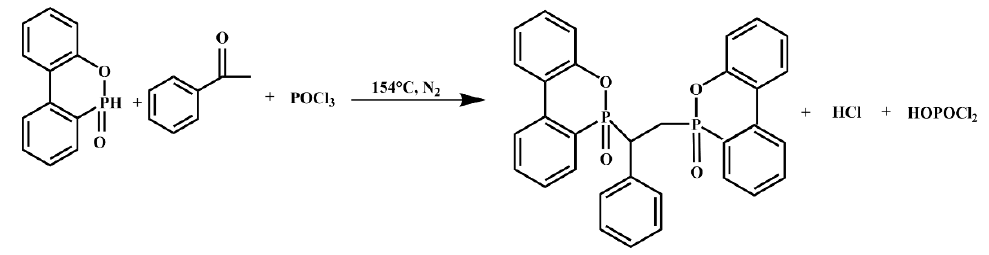
Figure 12. Synthesis route of PBDOO.